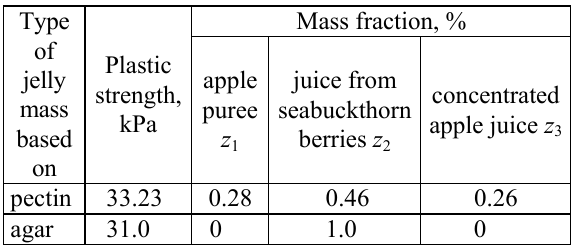
Table 3. Optimization results